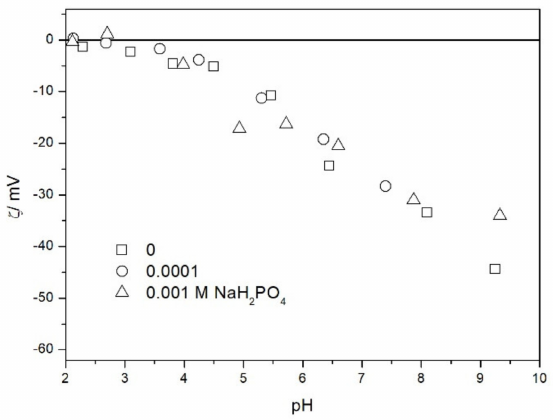
Figure 9. The zeta potential of TeO 2 in the presence of phosphate and 0.001 M